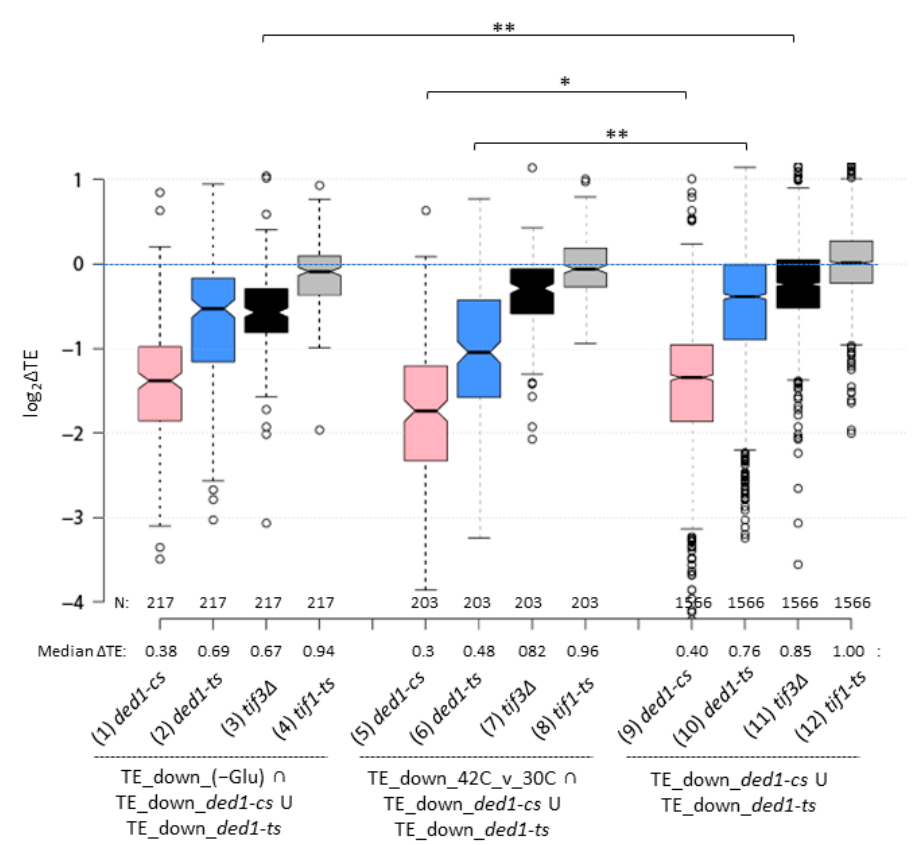
Figure 5. Elimination of eIF4B or inactivation of eIF4A preferentially reduces the TEs of a subset of Ded1-hyperdependent mRNAs down-regulated by glucose starvation. (A,B) Log 2 fold-changes in TE in response to the ded1-cs , ded1-ts , and either tif3 Δ (A) or tif1-ts (B) at 37 °C for the 1566 mRNAs showing 1.5-fold TE reductions in response to either ded1-cs or ded1-ts mutations (cols. 7–9) or the subsets of these mRNAs that also show TE reductions in response to either glucose starvation (217 mRNAs in cols. 1–3) or heat-shock at 42 °C versus 30 °C (203 mRNAs in cols. 4–6). p -values computed from Mann–Whitney U -test are given (* p < 0.05; ** p < 10 − 4 ).